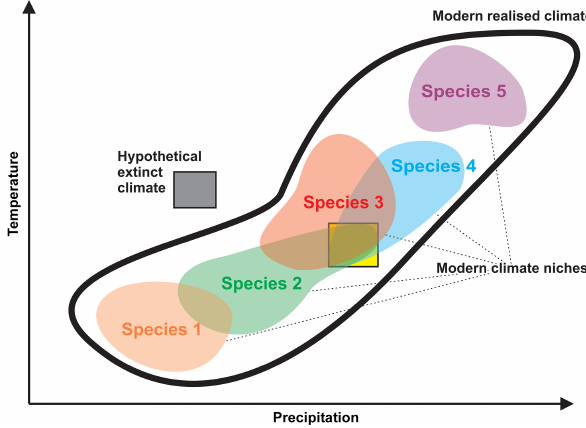
Figure 7. Impossibility of reconstructing extinct climates with the nearest-living-relative (NLR) principle. Shown are the (realised) cli- mate niches of five modern species, which, inevitably have to lie within the frame of the modern climate space. Any coexistence space (yellow square, showing the coexistence space of species 2, 3 and 4 using their minimum and maximum tolerances) must re- flect a climate situation also found today. Any extinct climate (grey square) could only be defined by the coexistence of species with climate niches different to those found in modern species, species with no living NLR or species belonging to lineages that underwent niche